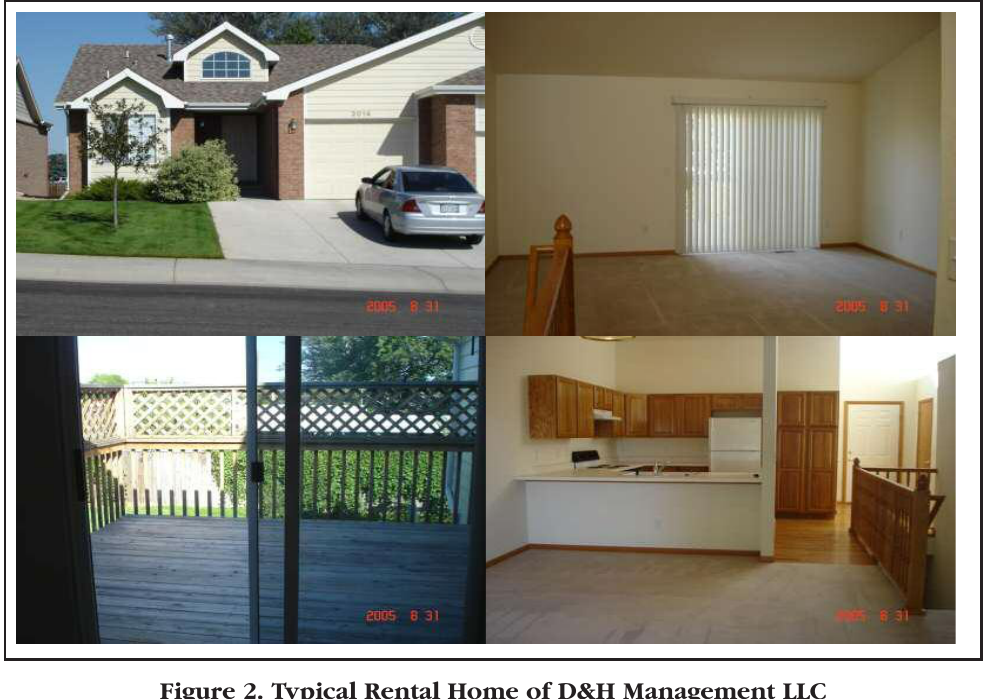
Figure 2. Typical Rental Home of D&H Management LLC